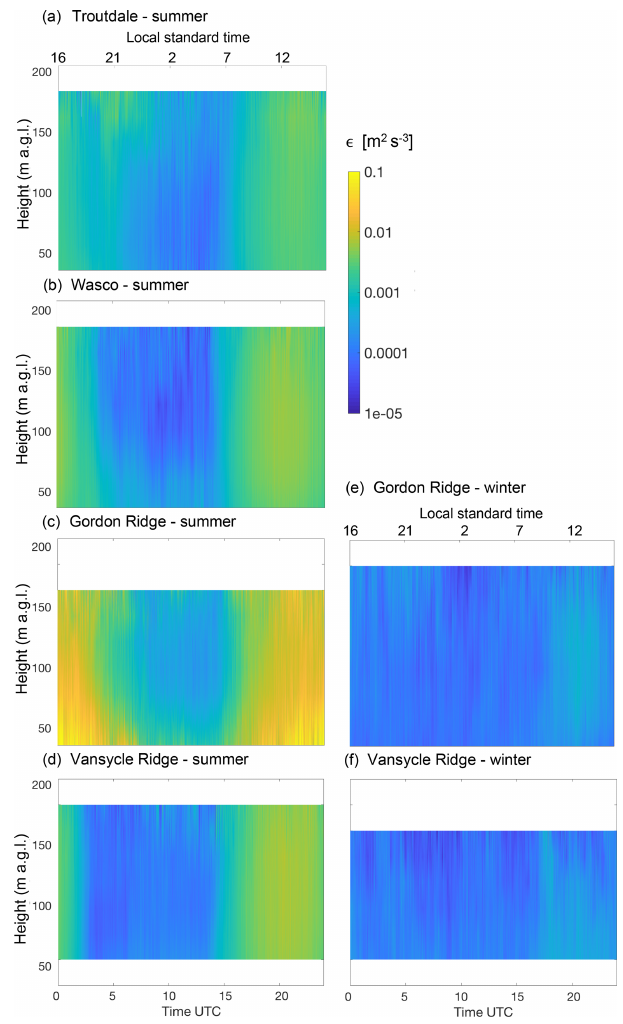
Figure 10. Average diurnal climatology of (cid:15) for the summer (1 June–31 August) from the WINDCUBE v1 at Troutdale (a) , the WINDCUBE v1 at the Wasco Airport (b) , the WINDCUBE v2 at Gordon Ridge (c) , and the WINDCUBE v2 at Vansycle Ridge (d) . Average diurnal climatology for the winter (1 December to 28–29 February) from the WINDCUBE v2 at Gordon Ridge (e) and the WINDCUBE v2 at Vansycle Ridge (f) . At this site, LST = UTC − 8.